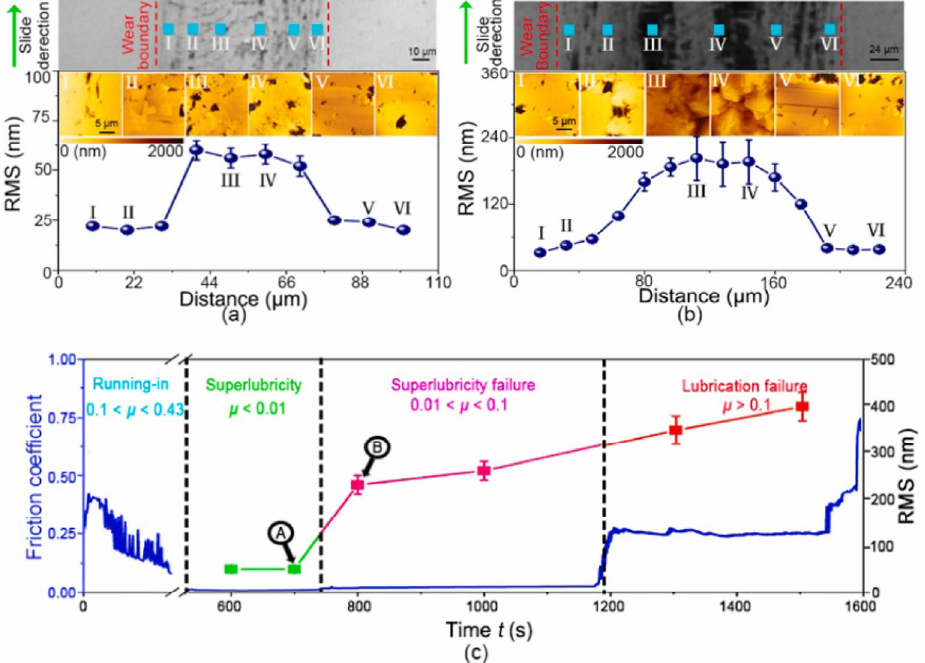
Fig. 4 Evolution of surface roughness in worn region on glass substrate characterized using AFM. (a) and (b) respectively show the variations of surface roughness in each AFM scanning area of 20 µm × 20 µm along the cross-section of wear scars formed at the sliding time of 700 s (marked with A in (c)) and 800 s (marked with B in (c)) corresponding to the stages of superlubricity and superlubricity failure. The upper optical pictures in (a) and (b) show the wear tracks with the widths of 100 and 200 µm formed under these two conditions. The middle insets of (a) and (b) show the representative AFM images (20 µm × 20 µm) of the worn regions marked in the upper optical pictures. (c) Root mean square (RMS) roughness of the center area (within 40 µm of scratch center) of wear track on glass substrate under different lubrication states obtained using AFM. F = 6 N and v = 0.5 m/s. The error band represents a standard deviation [32]. Reproduced with permission from Ref. [32], © Elsevier Ltd.,